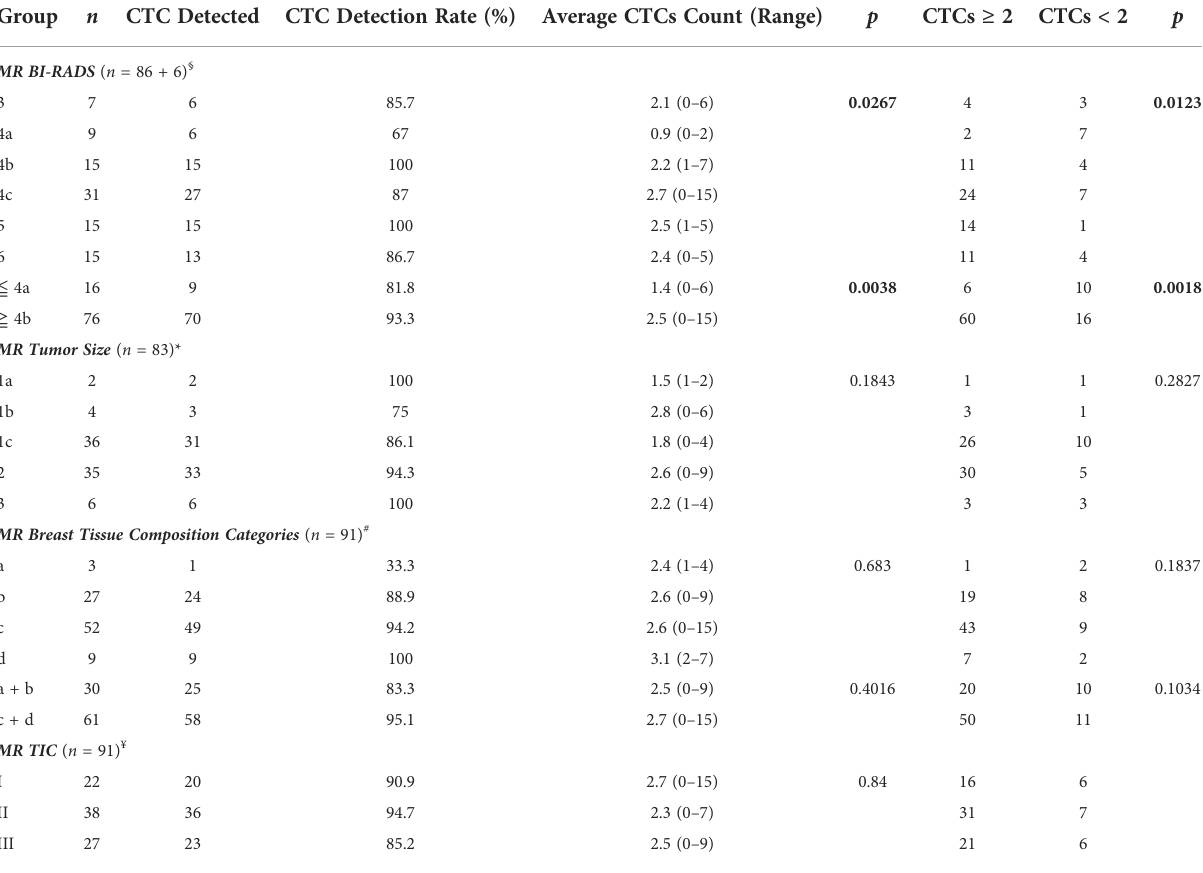
TABLE 5 Correlations of CTC tests and magnetic resonance imaging examination in BC diagnosis. Group n CTC Detected CTC Detection Rate